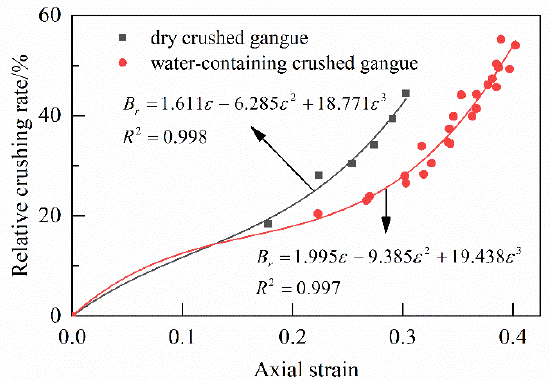
Figure 11. Relationship curves between relative crushing rate and axial strain.